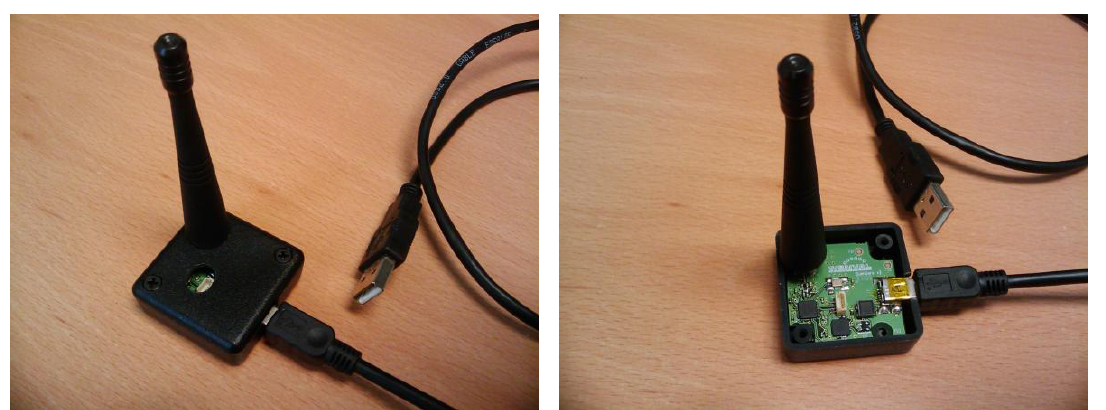
Figure 5. Views of the sink